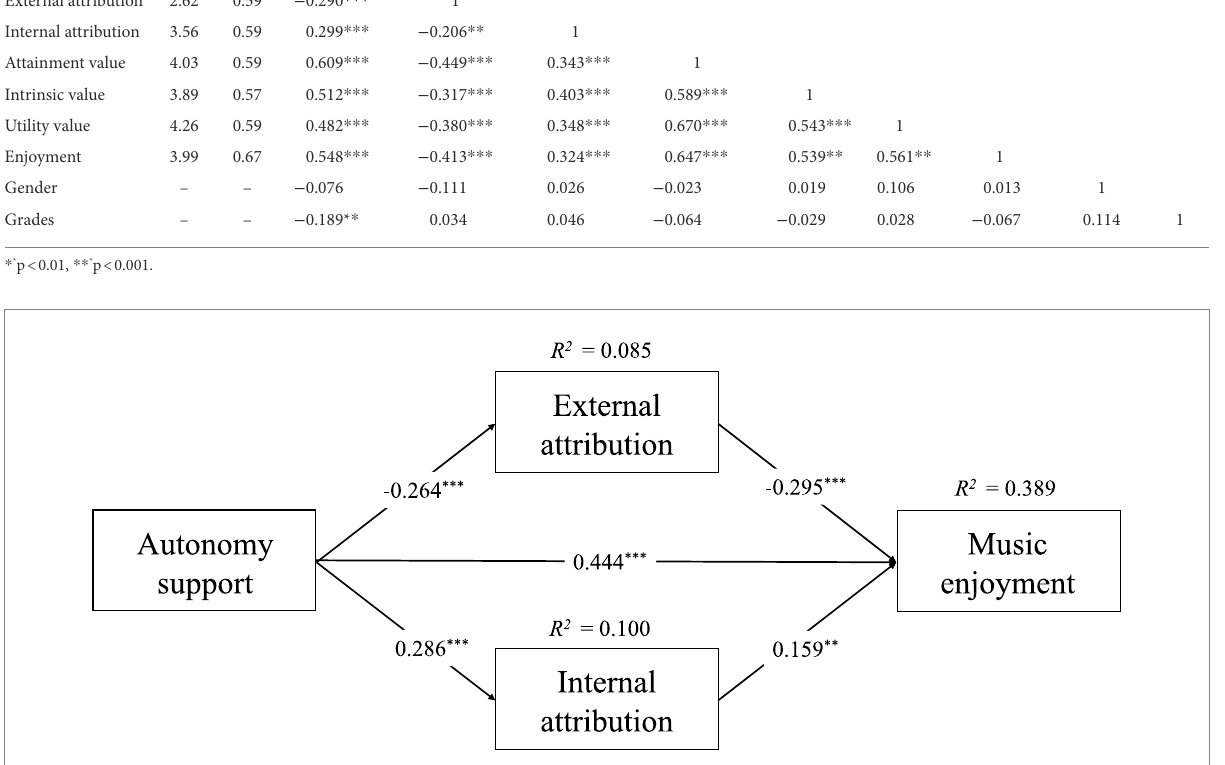
FIGURE 2 Mediation model of attributions between autonomy support and music enjoyment.